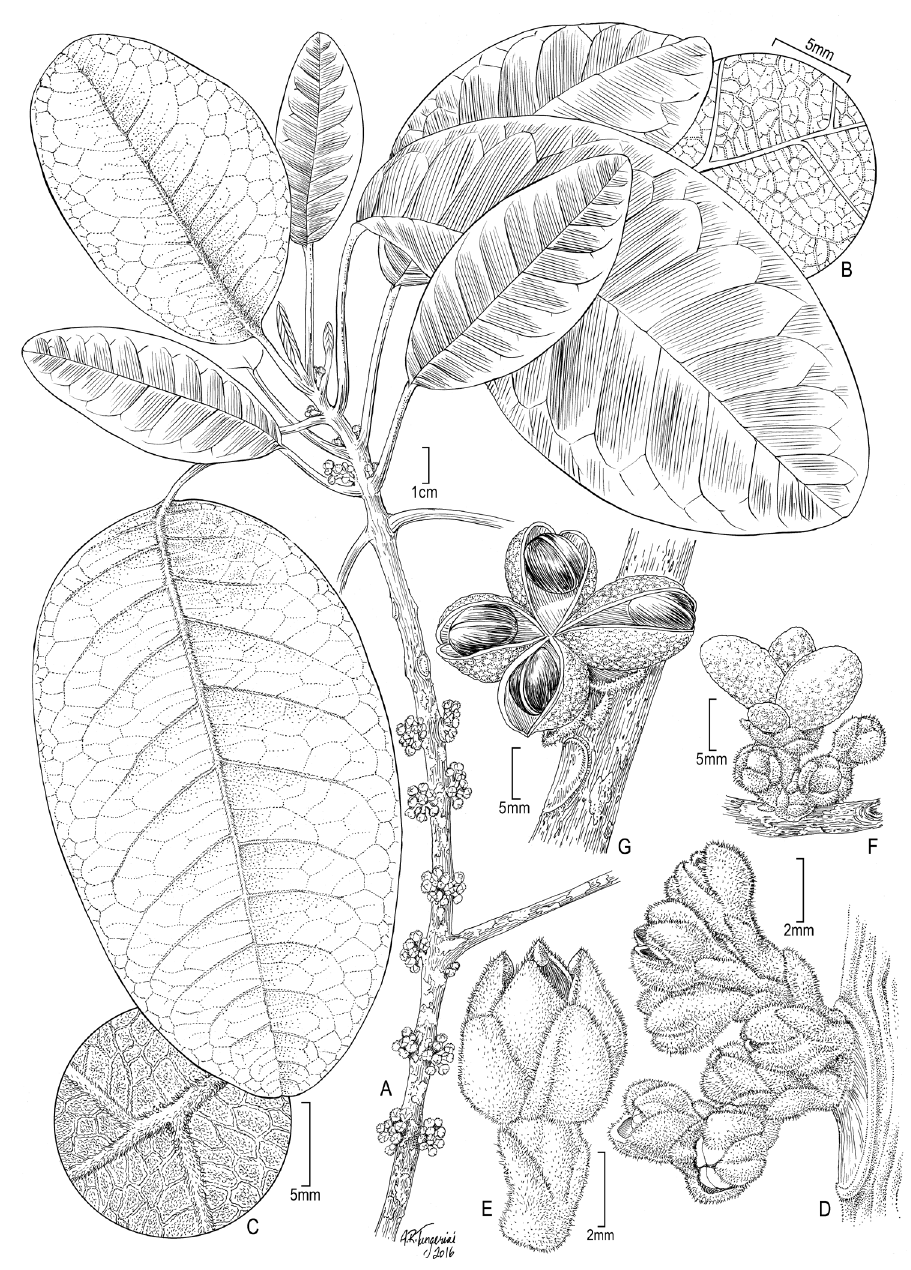
Figure 1. Melicope stonei K.R. Wood, Appelhans & W.L. Wagner. A Flowering branch B Adaxial leaf sur- face near margin toward apex C Abaxial leaf surface near margin toward apex D Ramiflorous inflorescence arising below leaves on stem E Female flower, lateral view F Immature fruit and flowers G Dehisced fruit, showing seeds. A - C from Wagner & Wood 6891 (US) D from Wood 8431 (US) E from Wood 15101 (PTBG) F from Wood & Lee 16729 (photo) G from Lorence et al. 6454 (photo) (Illustration by Alice